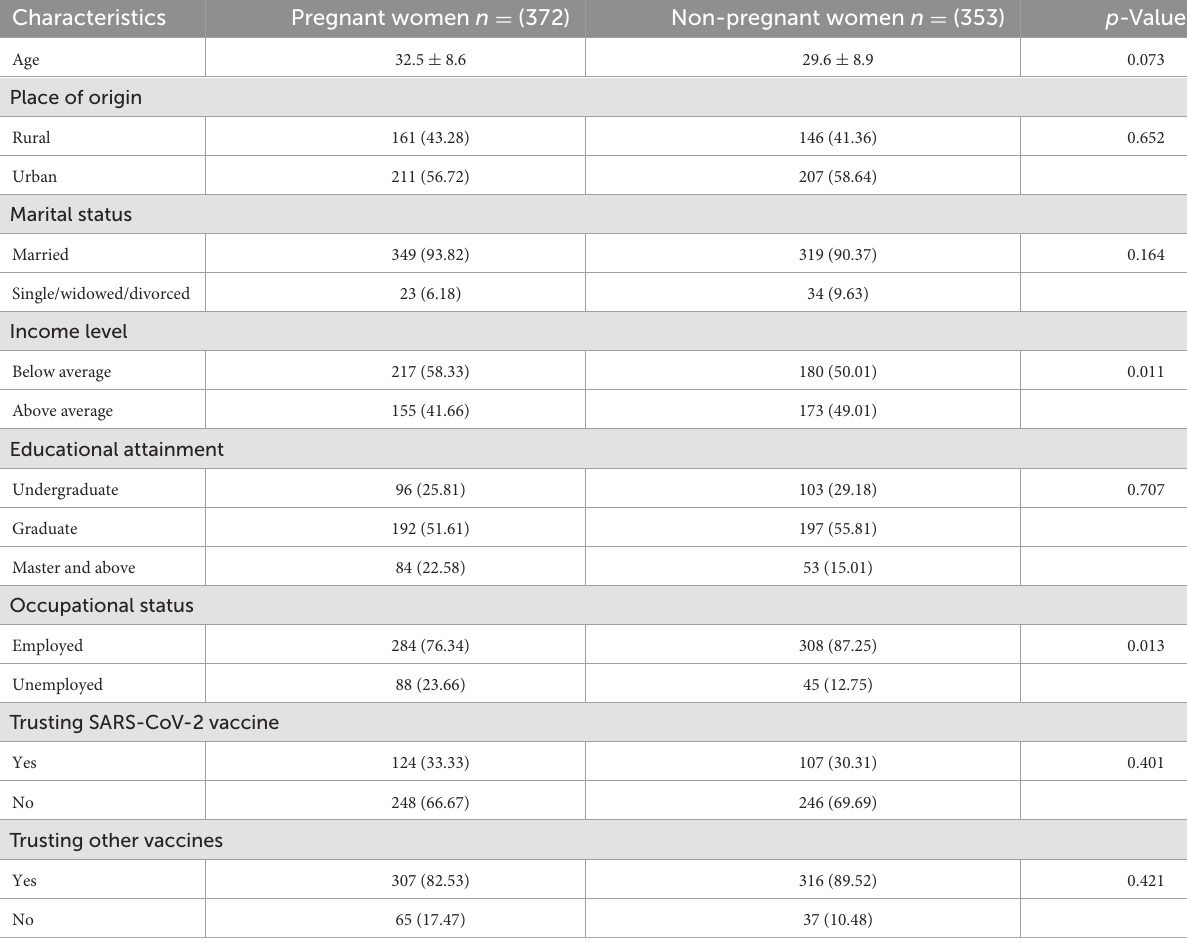
TABLE 1 Baseline characteristics of pregnant and non-pregnant study